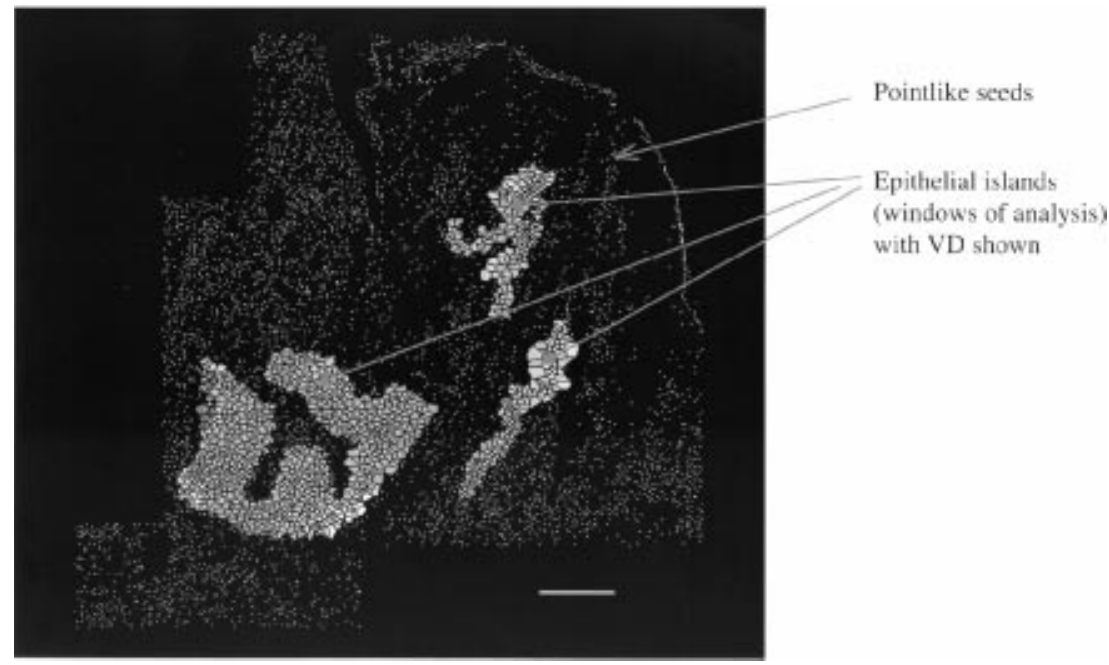
Fig. 4. VD with Voronoi polygons shown in pseudocolours, where the areas selected for analysis represent an epithelial island in the underlying stroma. Note in particular that border effects of marginal polygons (the polygons in the periphery of the analysis windows) have been eliminated. The sample is from the invasive front of an oral squamous cell carcinoma of the tongue. The scale bar is 0.5 mm.